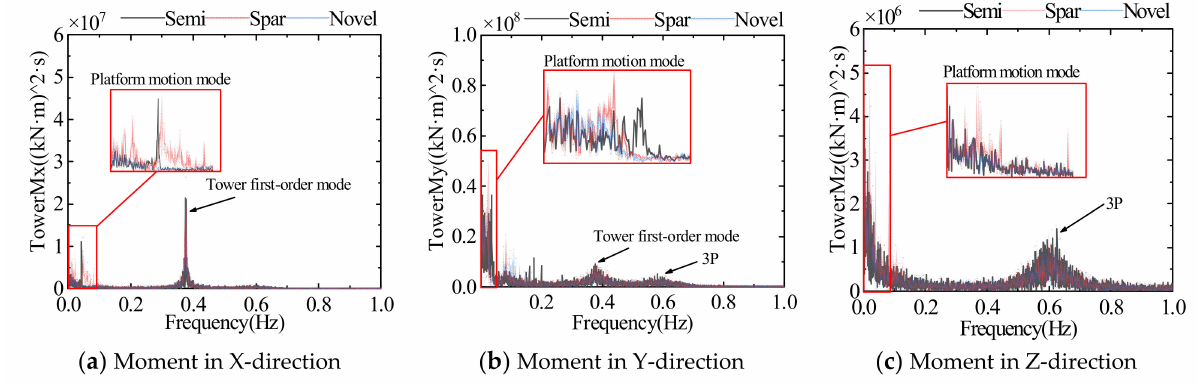
Figure 32. Power spectral density of tower base moment of three FOWTs.